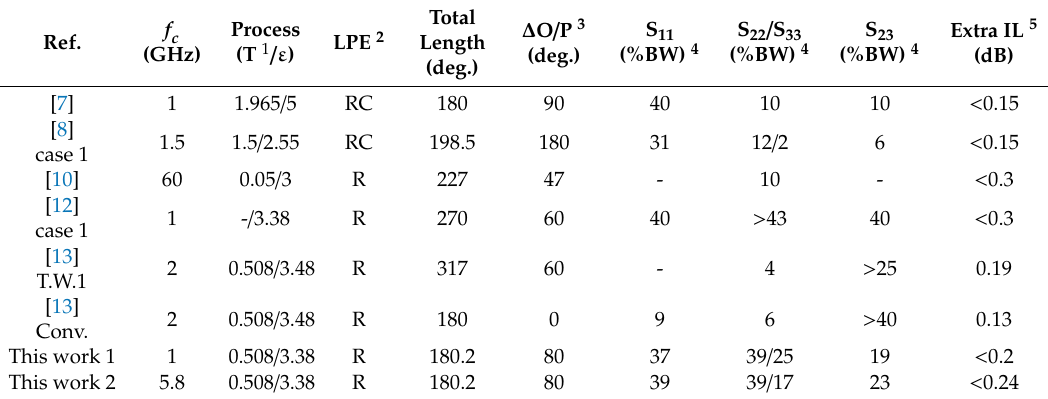
Table 2. Performance comparison of the two prototypes with previous published works.